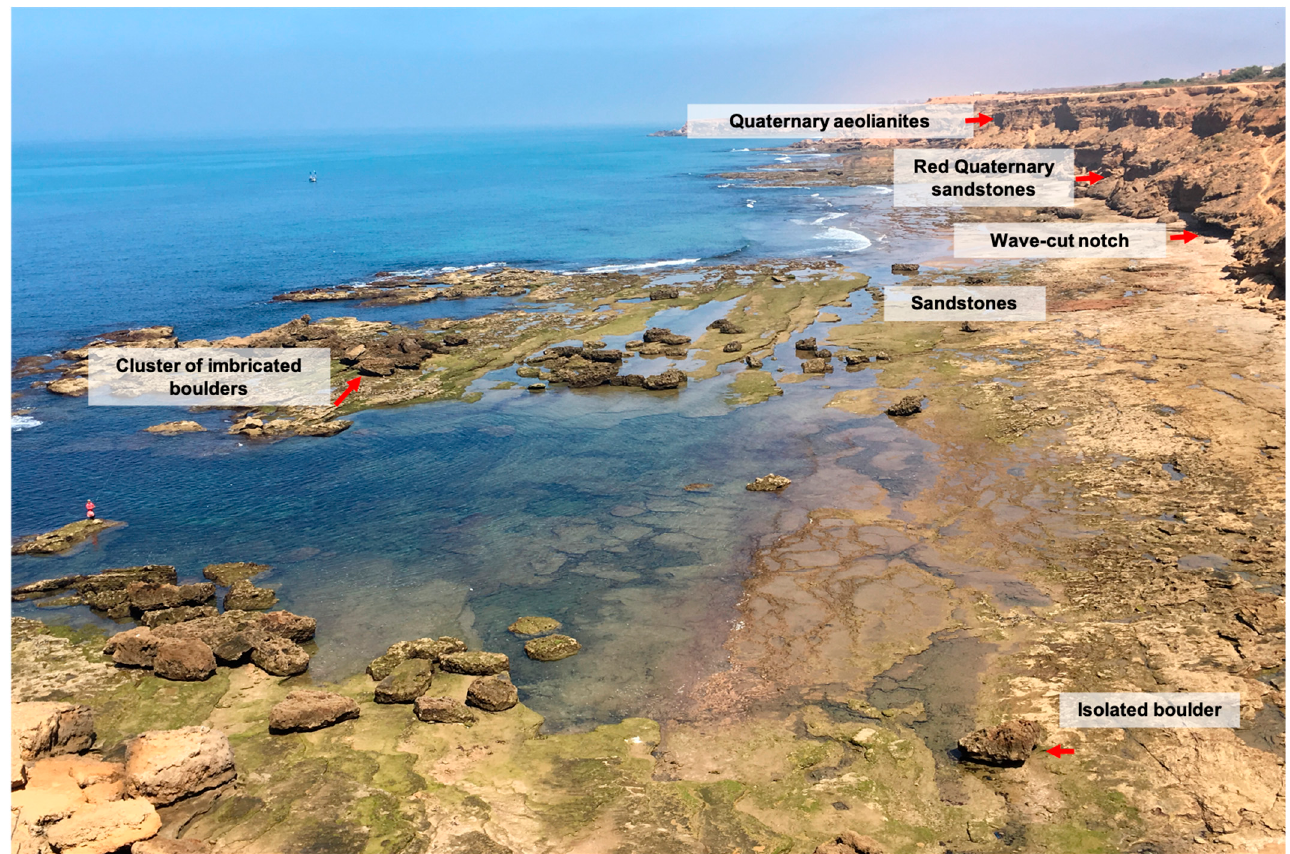
Figure 2. Oblique view of the shore platform at Laghdira, showing aspects of the lithology and geomorphology.